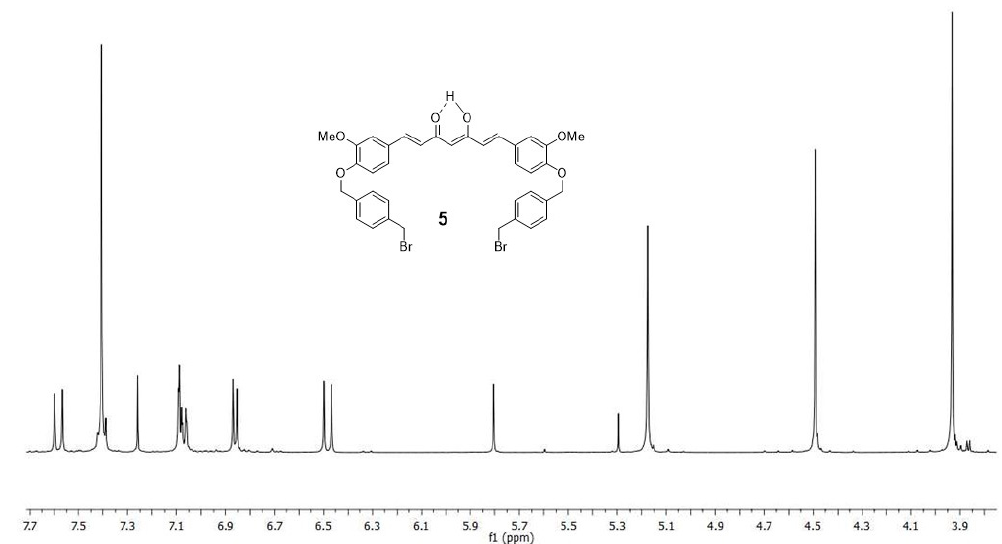
Figure 14. 1 H NMR spectrum of Compound 5 in CDCl 3 as solvent.